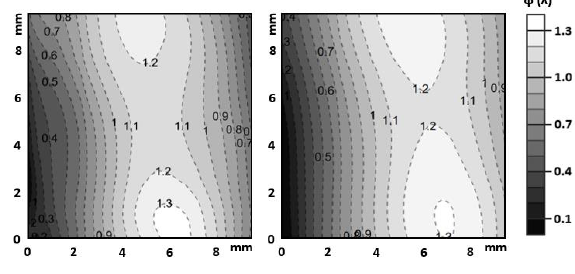
Fig. 3. Comparison of computer addressed map (left figure) and evaluated retardance (right